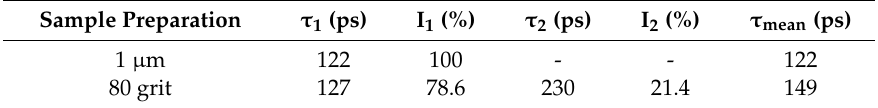
Table 2. Positron lifetime measured in 1 µ m polished and 80 grit ground Ni14Cr4Al